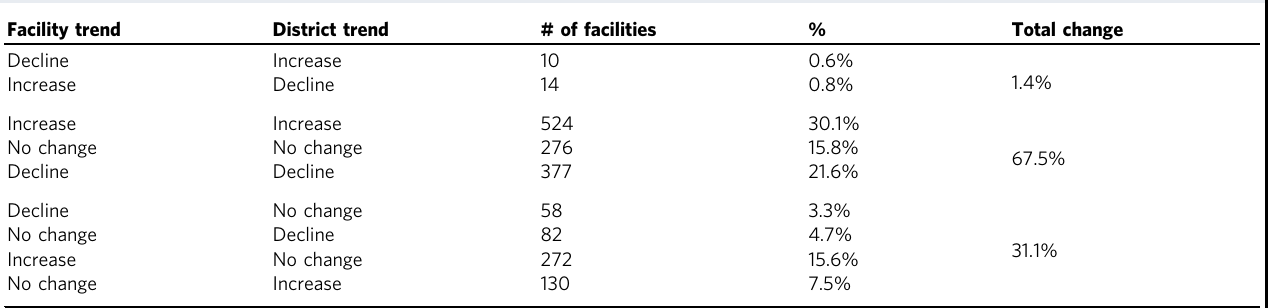
Table 1 Trend variation between district and health facility-level trend